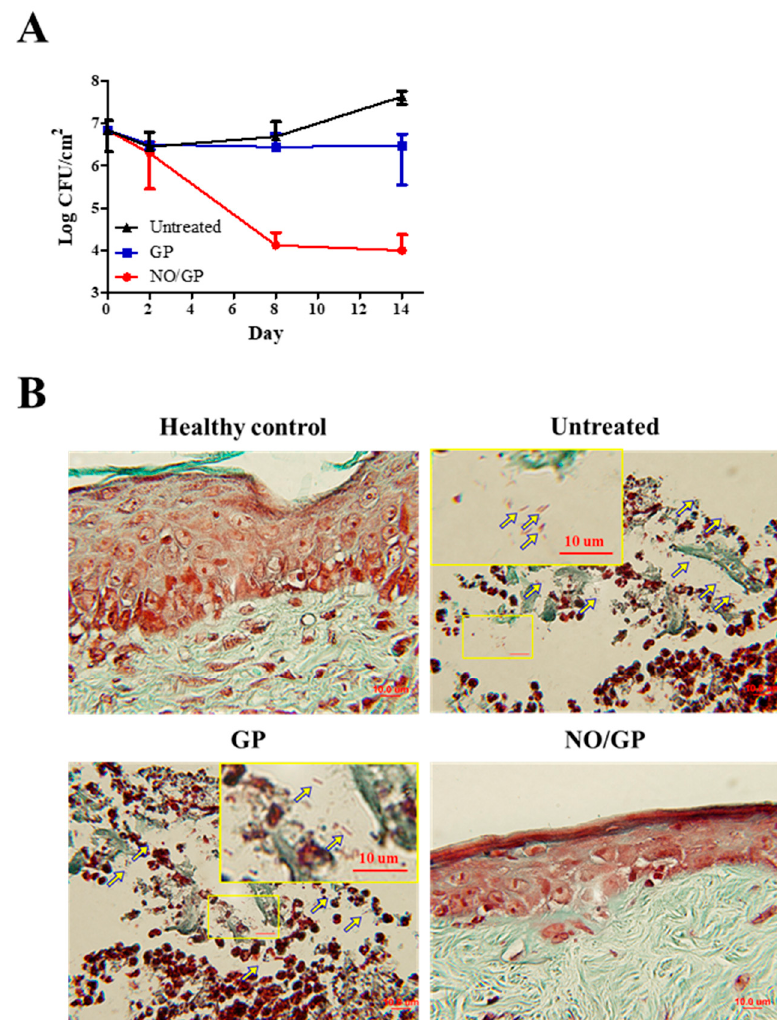
Figure 7. Bacterial quantification at the wound site ( n = 3) ( A ). Twort’s gram staining of wound samples from mice treated with or without GP or NO/GP. The epidermal region of the tissue samples was imaged with a microscope at a magnification of 100×. Arrows indicate P. aeruginosa (1–2 μ m sized, rod-shaped, and brown). Scale bar represents 10 μ m ( B ).